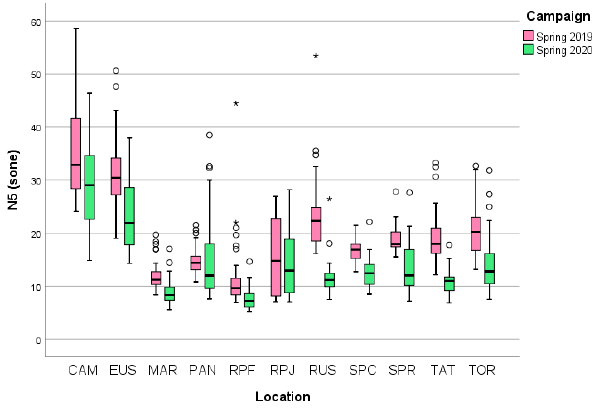
Figure 4: Loudness distributions at the 11 London locations (for Location IDs, see Table 1) before and during the lockdown measures